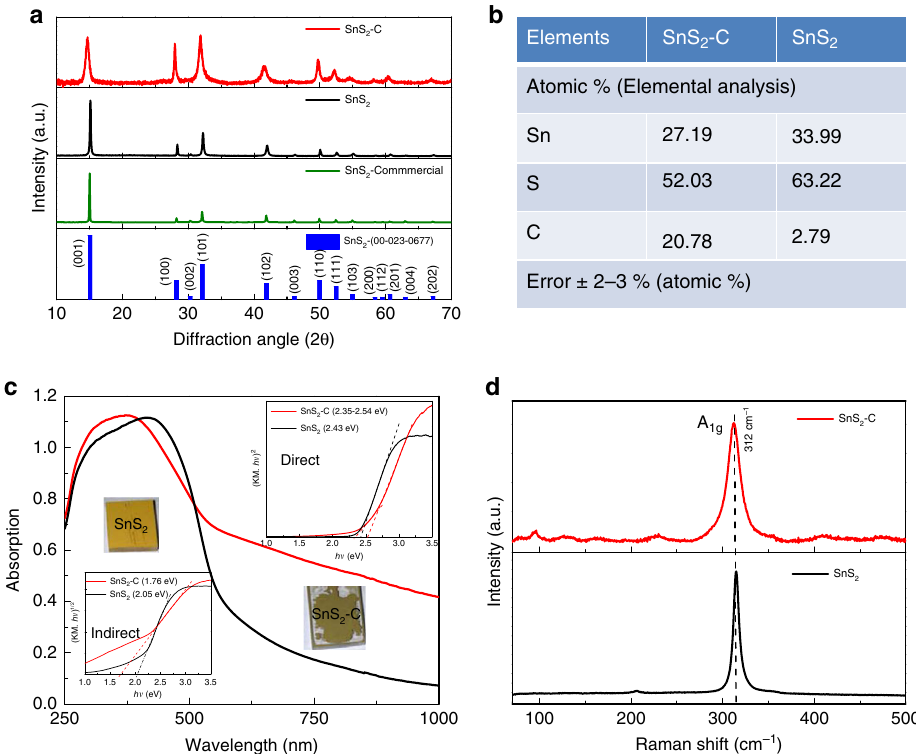
Fig. 1 Crystal structure and optical properties of SnS 2 -C and SnS 2. a XRD patterns of SnS 2 -C, SnS 2 and commercial SnS 2 . b Chemical compositions, c UV-vis diffuse re fl ectance and (insets) Tauc plots with both direct and indirect fi ttings, and d Raman spectra, of the SnS 2 -C and SnS